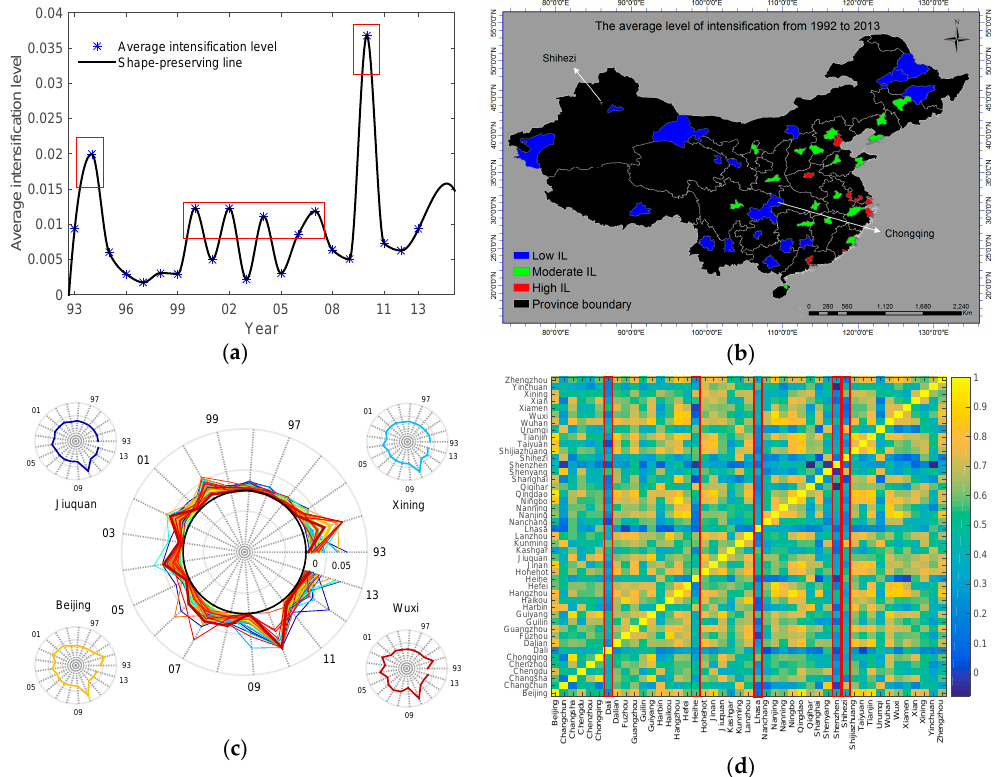
Figure 5. Characteristics of intensification: ( a ) Annual average IL over years; ( b ) Map of the average IL for each metropolitan from 1992 to 2013; ( c ) Polar plot of IL with time, where metropolitans are colored from blue to red according to its average value, and cities with the maximum, 30 percentiles, 70 percentiles, and the minimum average value of IL are Wuxi, Beijing, Xining, and Jiuquan respectively; ( d ) Spearman correlation coefficients of IL for each pair of metropolitans.